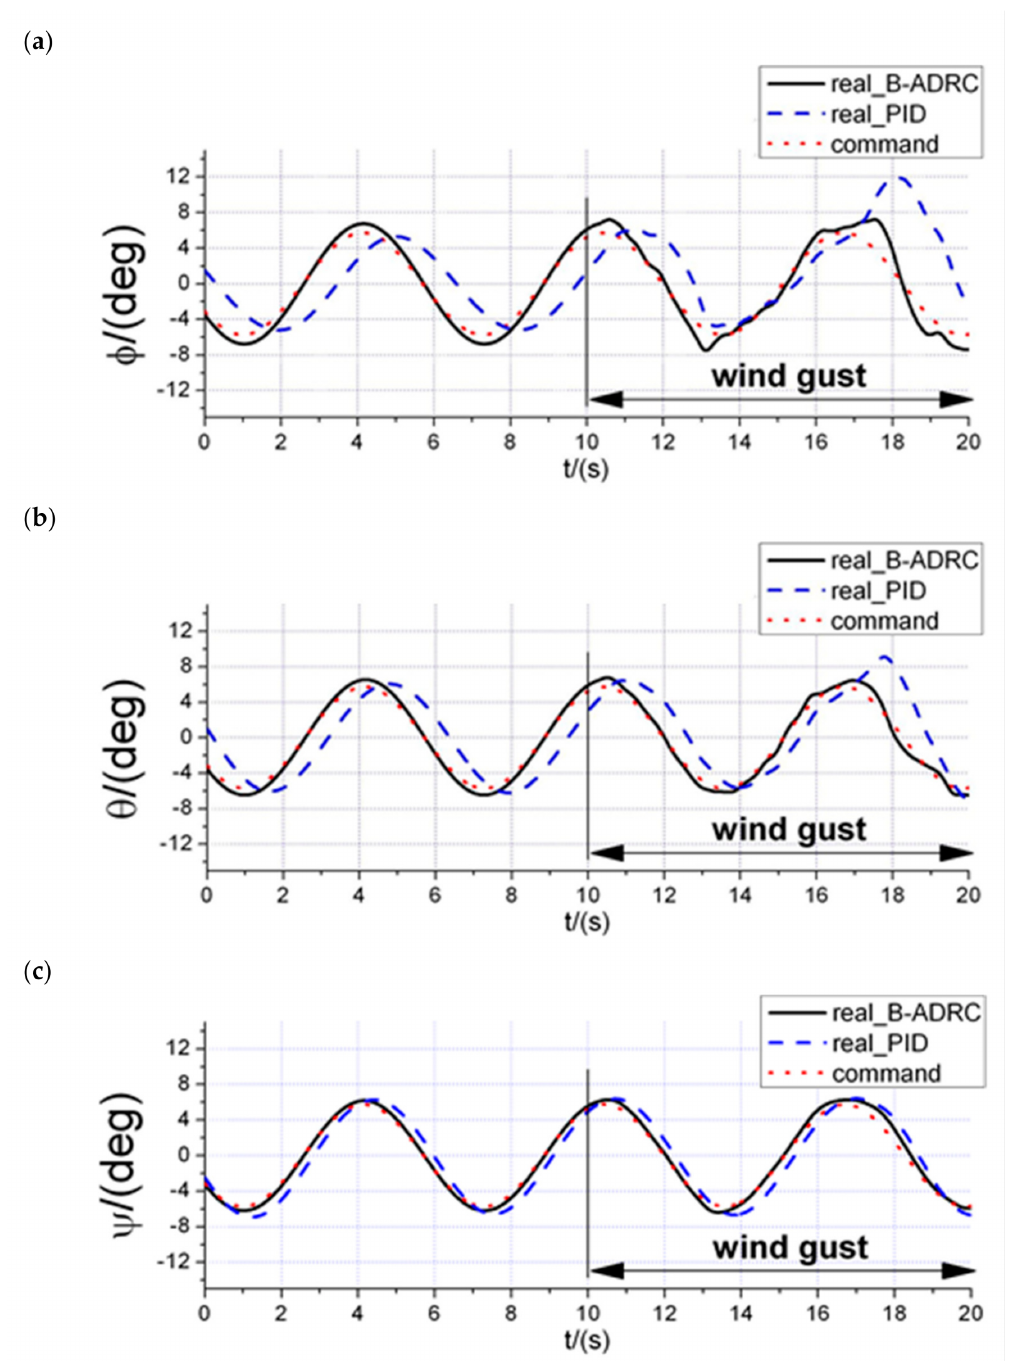
Figure 2. Attitude tracking without uncertainties. ( a ) Tracking of roll angle; ( b ) tracking of pitch angle; ( c ) tracking of yaw